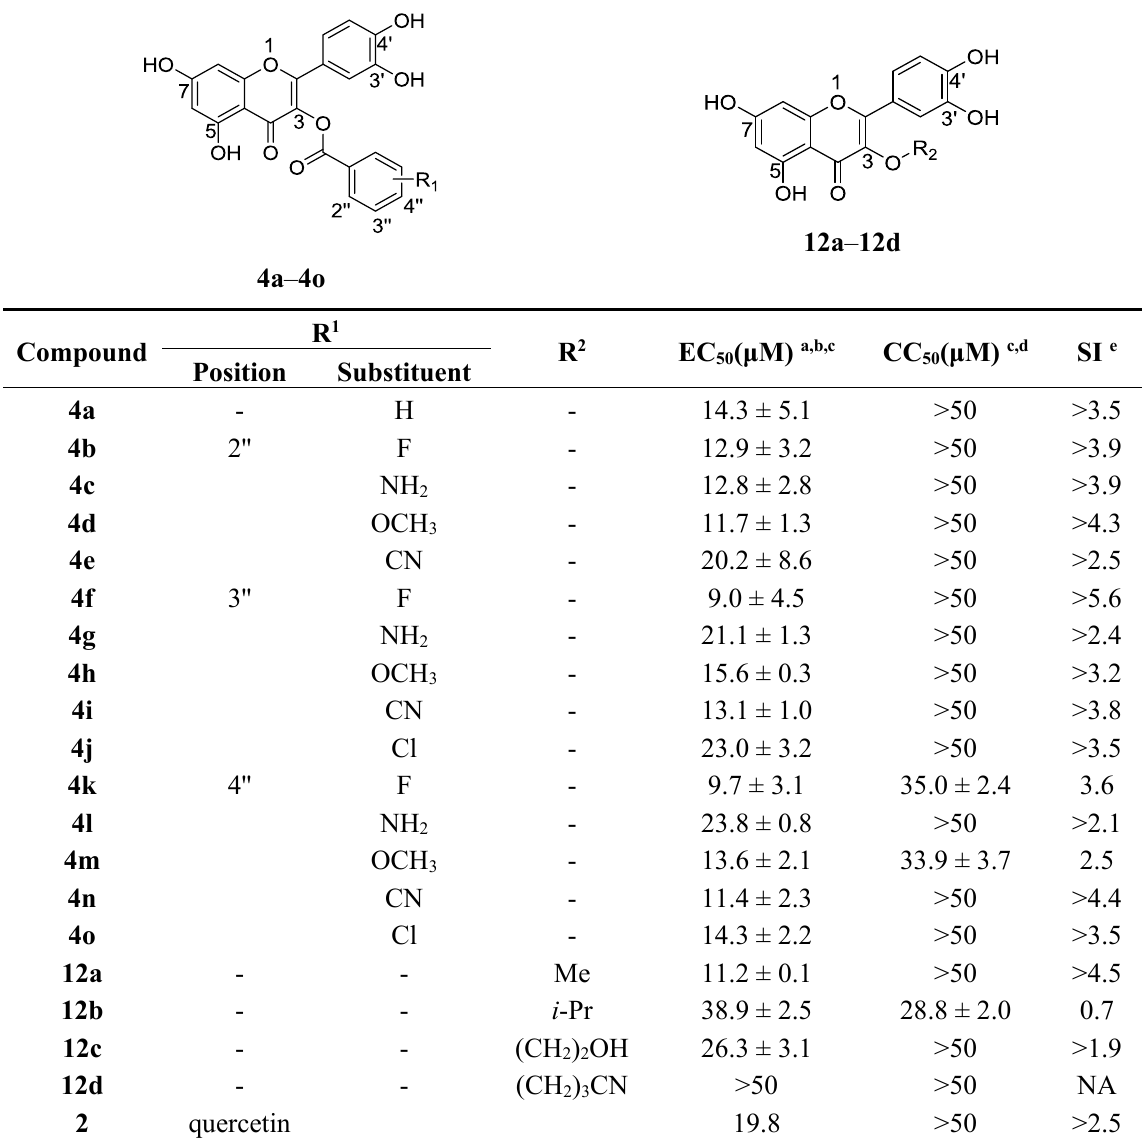
Table 2. Anti-HCV activities and cytotoxic effects of quercetin-3- O -substituted